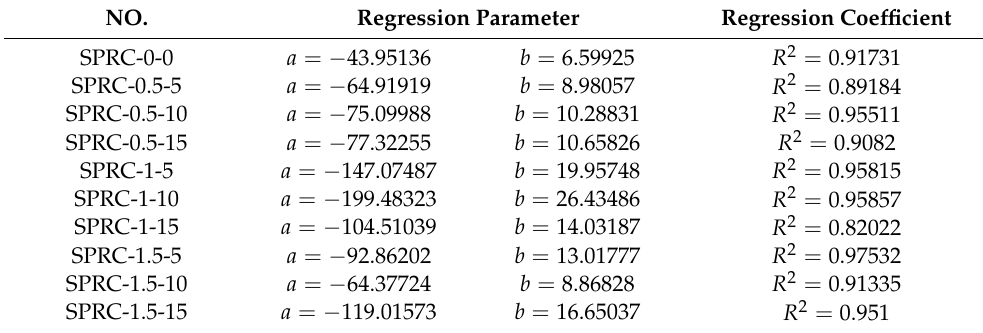
Table 5. Regression parameter values.